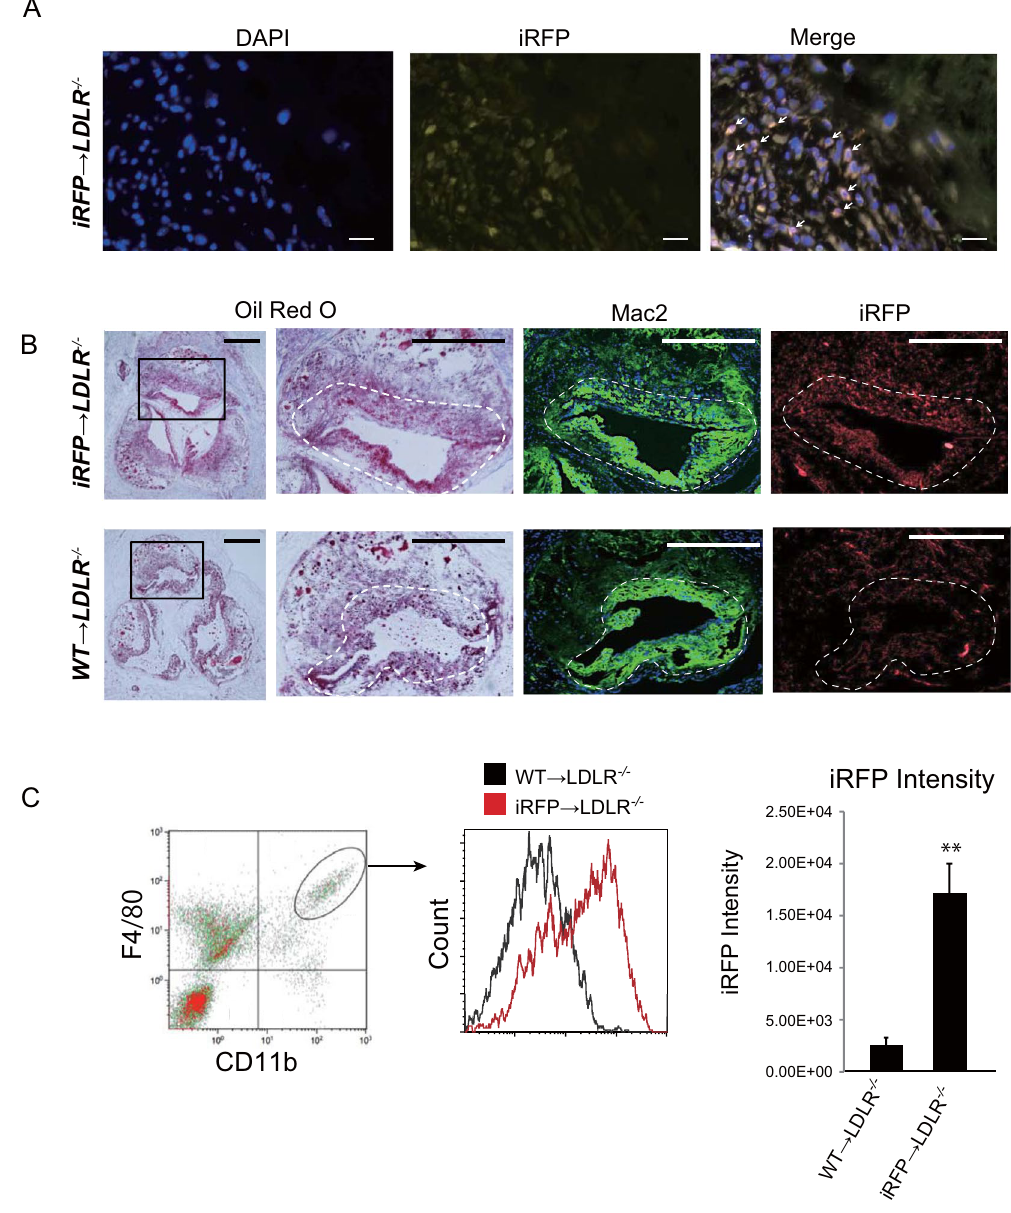
Figure 3. iRFP expressed in the atherosclerotic plaque macrophages is responsible for the plaque signal. ( A ) iRFP-positive cell accumulation was observed in the iRFP → LDLR − / − mouse atherosclerosis plaques under an iRFP-specific 720 nm filter (red, scale bar, 20 µ m). ( B ) Serial sections of atherosclerotic lesions around the aortic root of iRFP → LDLR − / − and WT → LDLR − / − mice fed the HCD for 8 weeks were stained with ORO and anti- Mac2 (macrophage marker, green), and the unstained adjacent section was observed under a Cy5.5 filter for iRFP expression (red; scale bar 500 µ m for the first column and 100 µ m for the rest). The macrophage-rich plaque area is marked by dotted lines. ( C ) The intensity of iRFP fluorescence expression in WT → LDLR − / − and iRFP → LDLR − / − plaque macrophages was assessed by flow cytometry after 8 weeks of atherosclerosis induction in digested mouse aortas. iRFP expression was measured in the CD11b and F4/80 double-positive cell fraction. The data are from one representative experiment of at least two independent